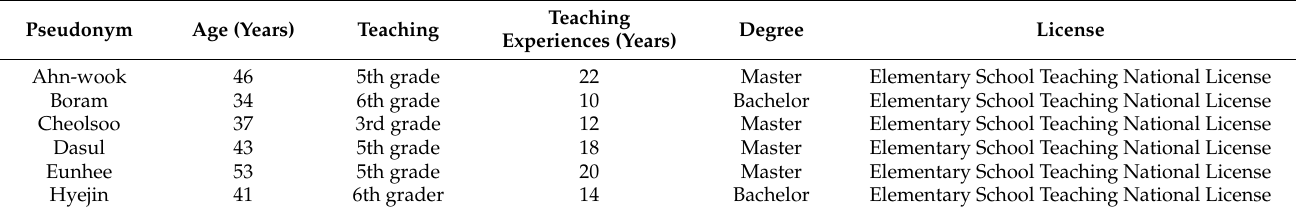
Table 1. Description of